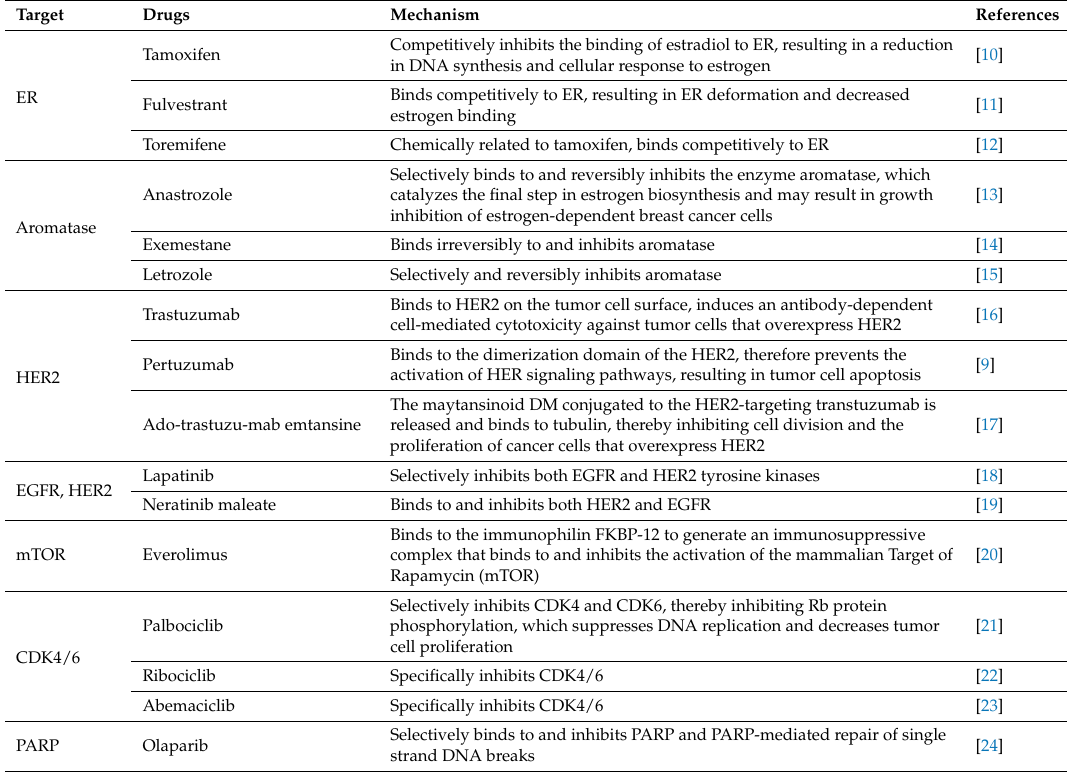
Table 1. Approved targeted drugs for breast